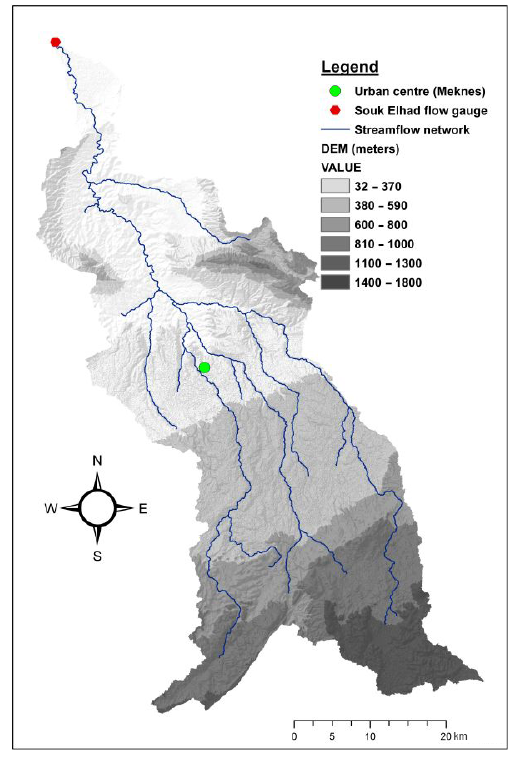
Figure 1. Digital elevation model of R’dom watershed.